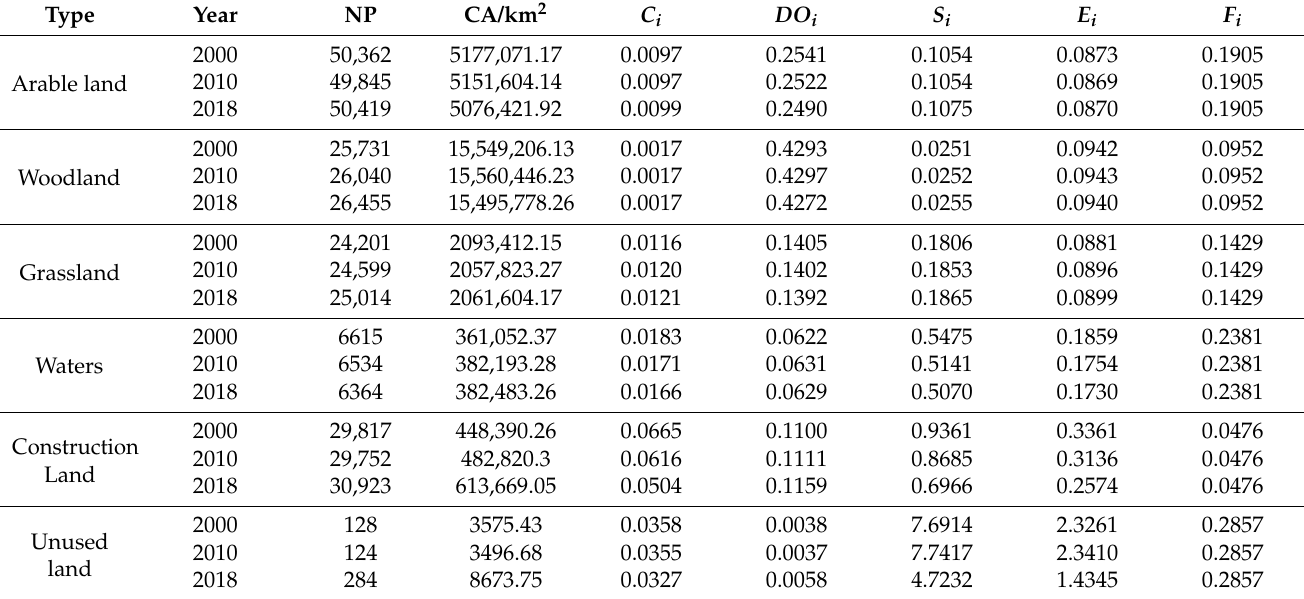
Table 5. Landscape pattern indices of different land-use